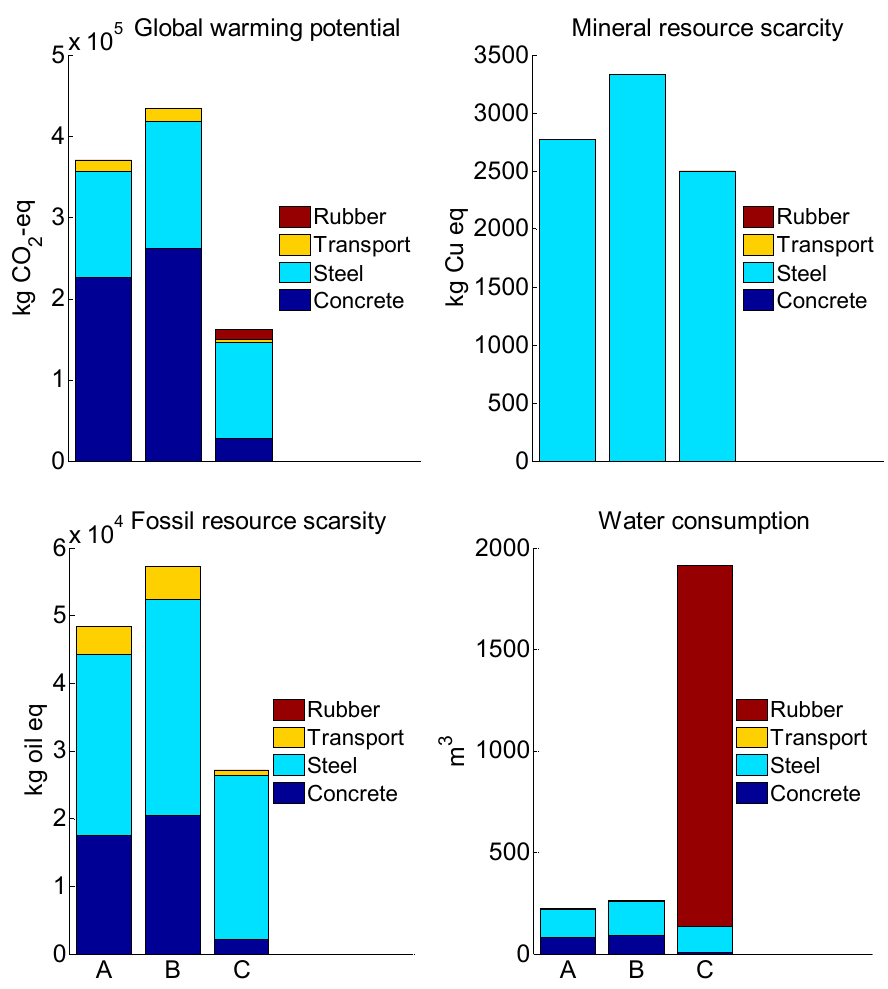
Figure 8. (A) Case 1, (B) Case 2, and (C) Case 3 evaluated with the ReCiPe 2016 midpoint method [42].